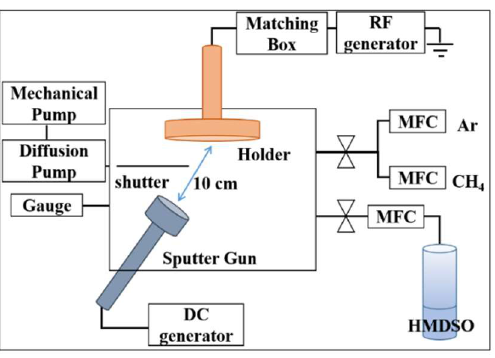
Figure 1. Schematic diagram of the apparatus used for deposition of SiO x : diamond-like carbon (DLC) films. Radio frequency (RF), hexamethyldisiloxane (HMDSO), mass flow controller (MFC).